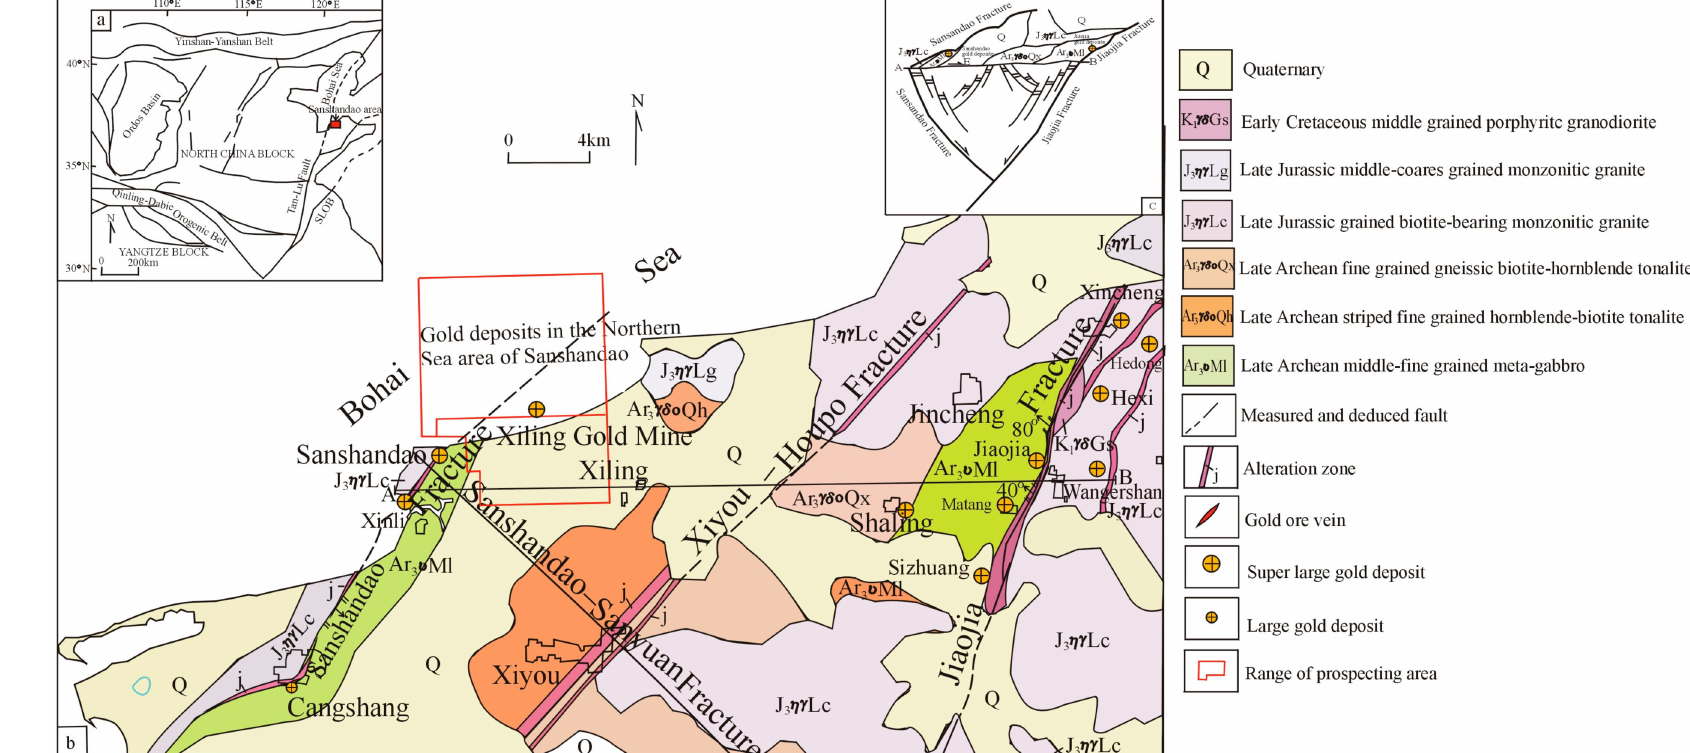
Figure 1. Geological map of the Sanshandao area. ( a ) Regional location map, from [1]; ( b ) geological map, modified after [44]; ( c ) geological structure sketch of A–B